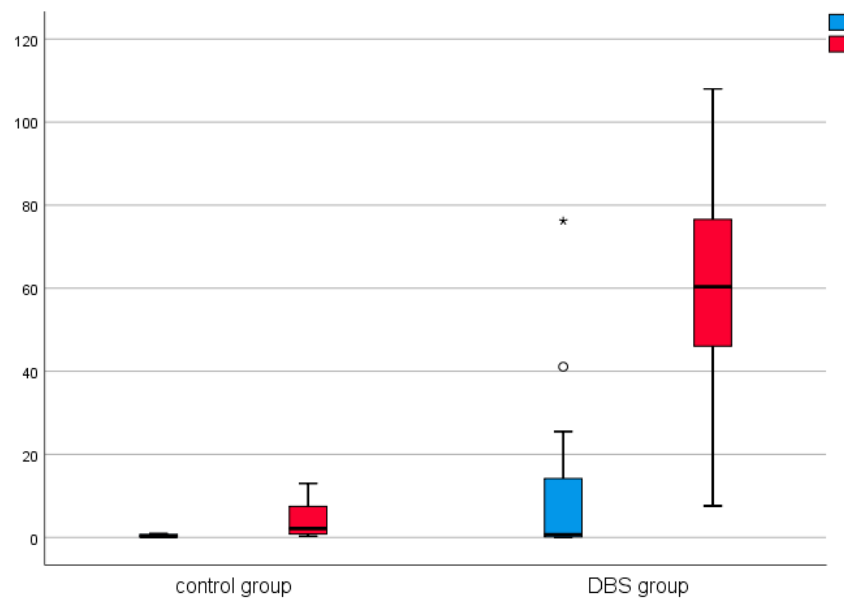
Figure 4. Effect of lesional surgery and DBS on C-reactive protein (CRP) levels (mg/L), (°—outliers ≦ 3SD, *—outliers > 3SD).